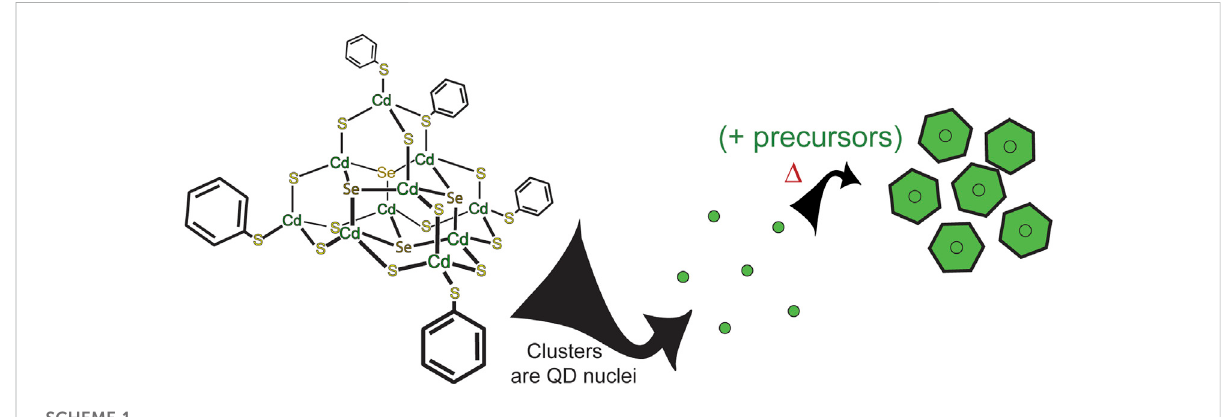
SCHEME 1 The cluster seed